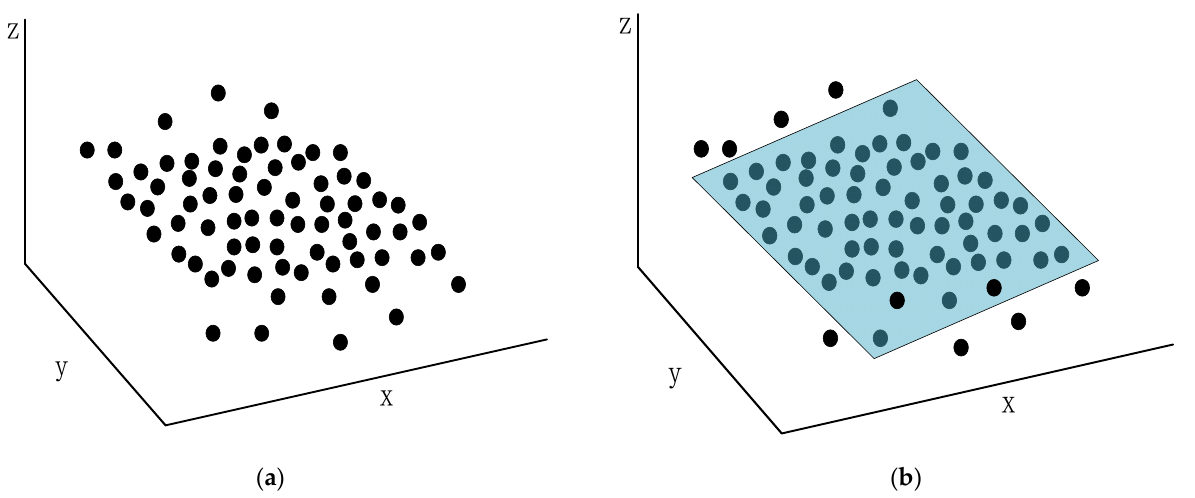
Figure 7. The RANSAC algorithm fitting plane points: ( a ) Original points; ( b ) The plane detected by the RANSAC algorithm. Figure 8. ( a ) Raw data; ( b ) The region growing algorithm; ( c ) The proposed method.